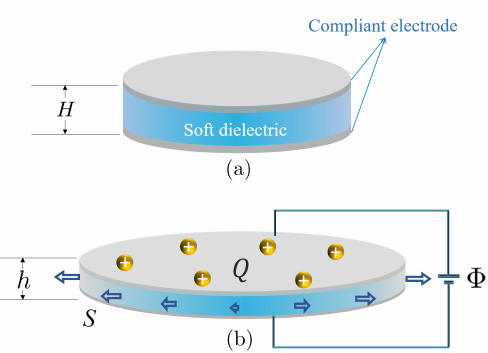
Figure 1. Schematic of the deformation of a circular film of soft dielectrics subjected to an electric voltage Φ and a surrounding dead load S . The circular film is coated with two compliant electrodes on the upper and bottom surfaces. ( a ) Undeformed circular film with radius B and thickness H . ( b ) Deformed circular film with thickness h . Each electrode gains an electric charge of magnitude Q